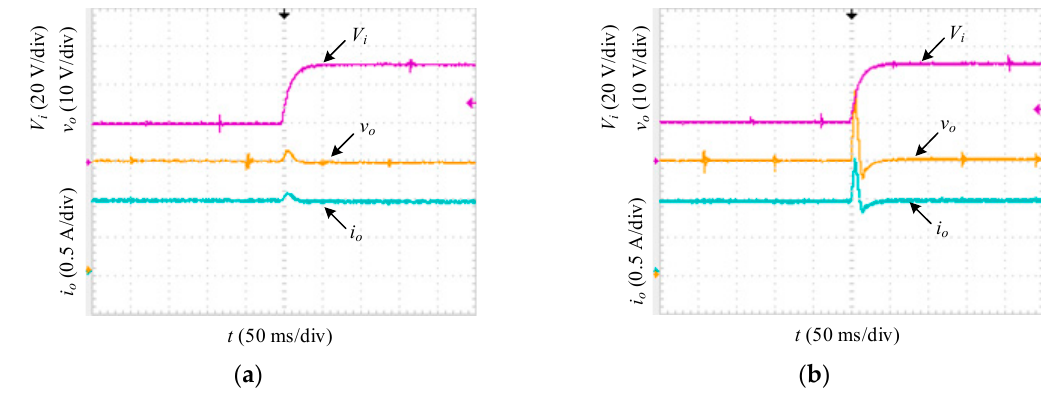
Figure 13. Waveforms of voltage and current of a buck–boost converter with a pure resistive load under power supply disturbances: ( a ) inverse-system decoupling controller; ( b ) conventional double closed-loop controller.